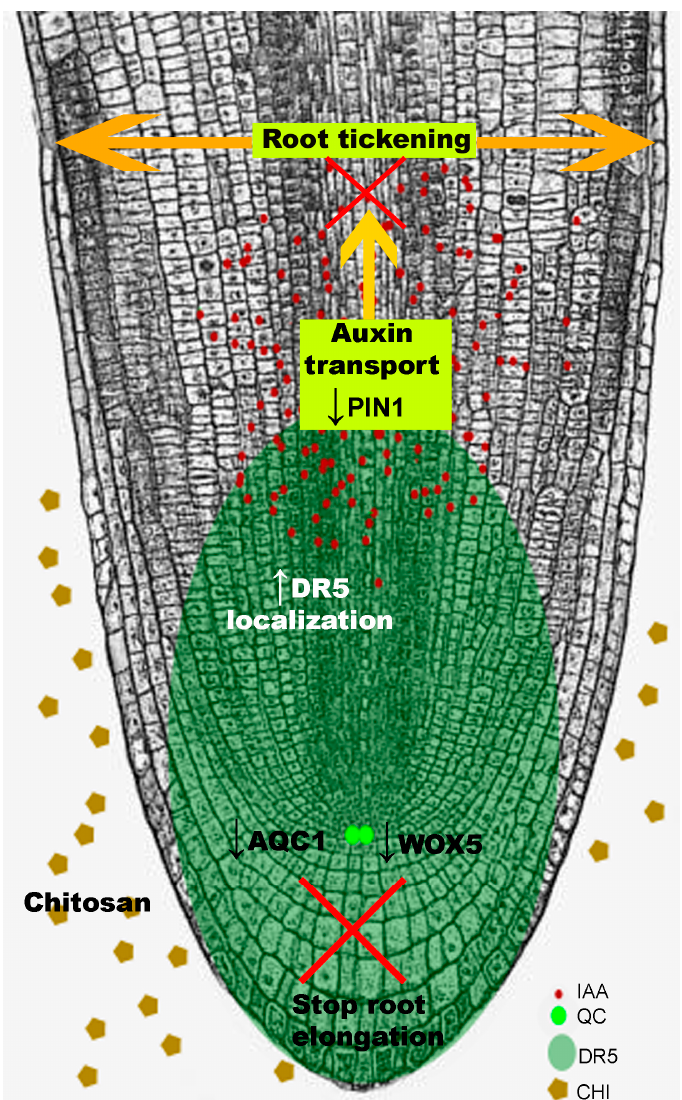
Figure 4. Chitosan causes auxin accumulation in roots. This is shown by lack of auxin transport in the vascular system (no DR5 expression). This auxin accumulation represses wox5 , which controls activity of the quiescent center and in turn root polar growth. As a result, root stops elongating and root apex thickens. ROS and phenolic accumulation are associated with programmed cell death and stress-hormone (JA, SA)